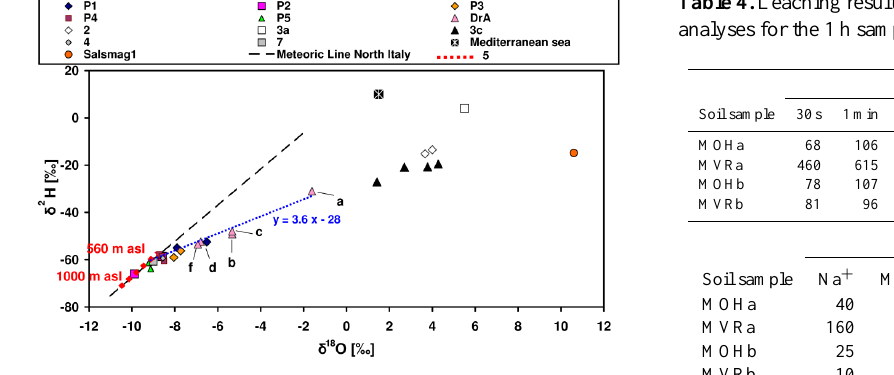
Fig. 6. δ 18 O- δ 2 H diagram. DrA point sampling campaigns are re- ported. Point: 2, 4 (Boschetti et al., 2010) – baths; 3a (Conti et al., 2000), 3c (Capozzi and Picotti, 2010) – mud volcanoes; 7 (Ven- turelli et al., 2003) – spring; SalsMag1 (Boschetti et al., 2010) – oil well. Red dashed line was obtained from sampling group 5 – com- mon shallow groundwater. Blue line represents the alignment of the δ 2 H depleted samples at Ca’ Lita. Black dashed line is the northern Italy meteoric line (Longinelli and Selmo, 2003).